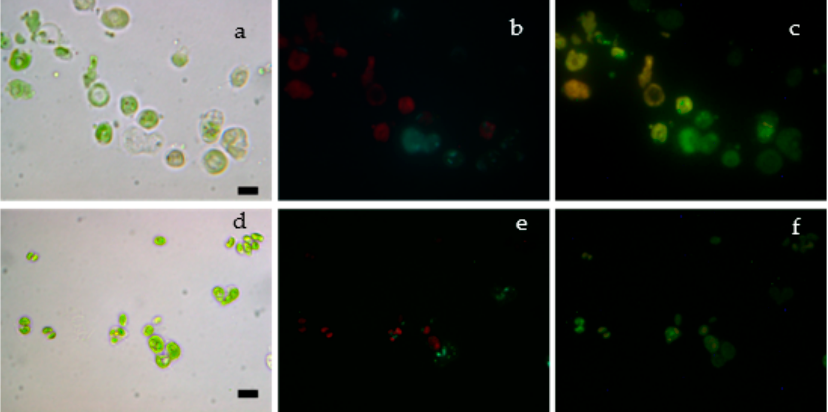
Figure 7. ( a , d ) Bright field microalgae cells; ( b , e ) nuclei are stained with fluorescent Hoechst stain (cyan). The red colour in cells is due to the autofluorescence of microalgae cells; ( c , f ) siRNA oligos emit fluorescent green light. Bar size: 10 μ m.